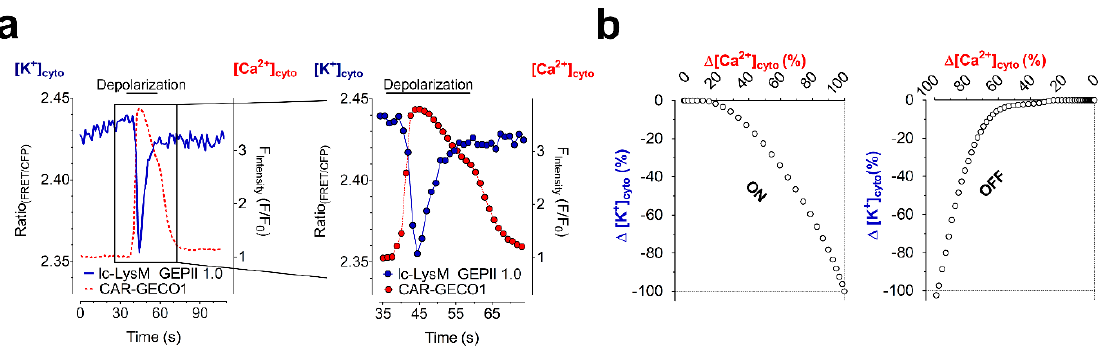
Figure 4. Co-expression of genetically encoded metal ion indicators allows the correlation of intracellular Ca 2+ with K + dynamics on the single cell level. ( a ) Representative single cell response of an INS-1 832/13 cell, a pancreatic β -cell, expressing lc-LysM GEPII 1.0 (blue curve, both panels), a genetically encoded, FRET-based K + indicator, and CAR-GECO1, a far-red fluorescent, single FP- based Ca 2+ sensor (red curve, both panels). At the time point indicated in the panels, cells were depolarized by the application of 70 mM K + . The right panel demonstrates a zoom of the area indicated in the left panel. Single time-points measured during the depolarization are indicated (right panel, blue and red circles). ( b ) Analysis of the on- (left panel) and off-kinetics (right panel) of the intracellular K + and Ca 2+ transient upon cell depolarization as demonstrated in ( a ).